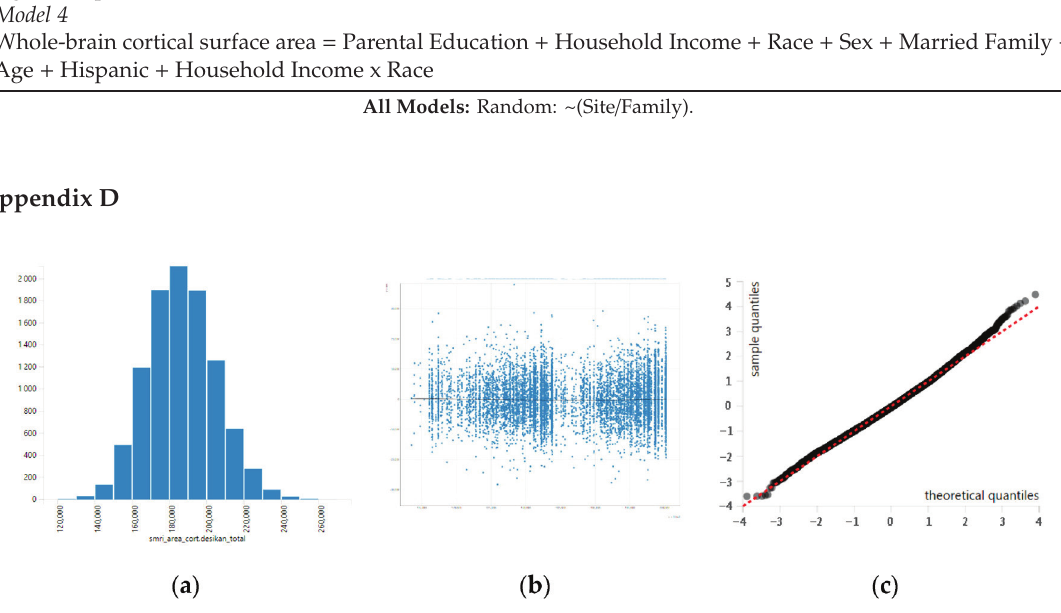
Figure A2. Testing assumptions of our models. ( a ) Histogram showing normal distribution of our outcome, ( b ) residuals of our model, and ( c ) association between observed and theoretical quantiles of our